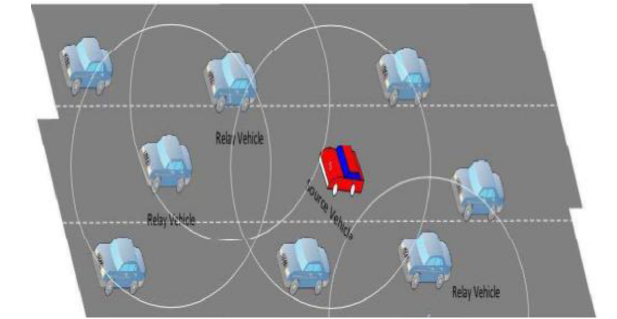
Figure 1. Data Dissemination in VANET